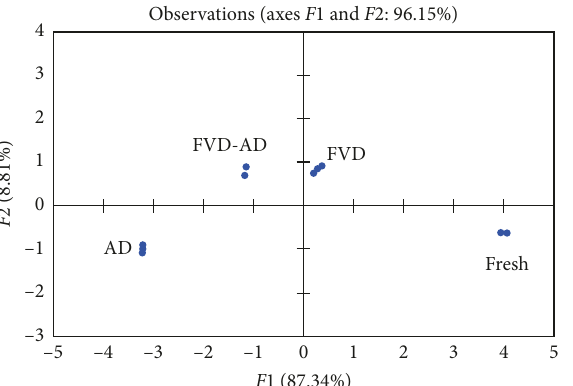
Figure 6: Principal component analysis plot of data for different sensory quality, antioxidant properties, and drying efficiency of kiwifruit samples. FVD: freeze vacuum drying; AD: air drying; FVD-AD: combined drying consisting of freeze vacuum drying and air